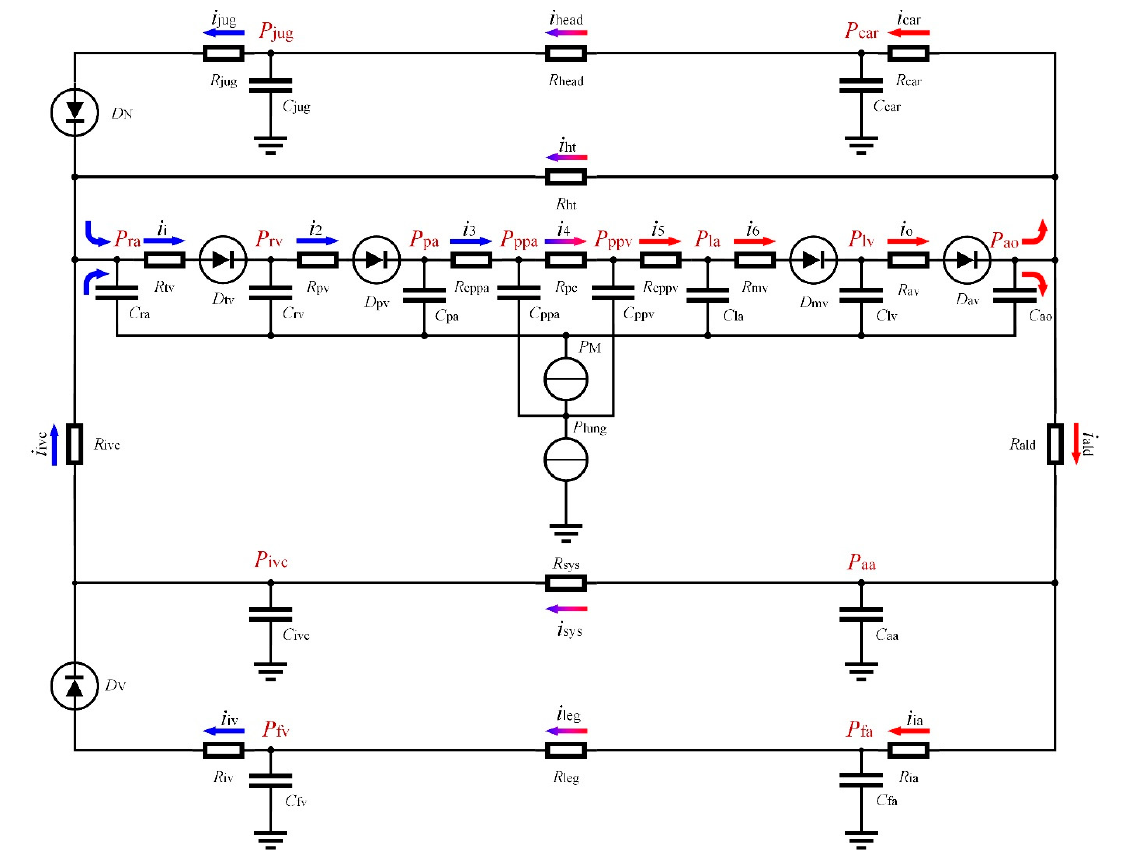
Figure 7. Circuit diagram of the human blood circulation model.